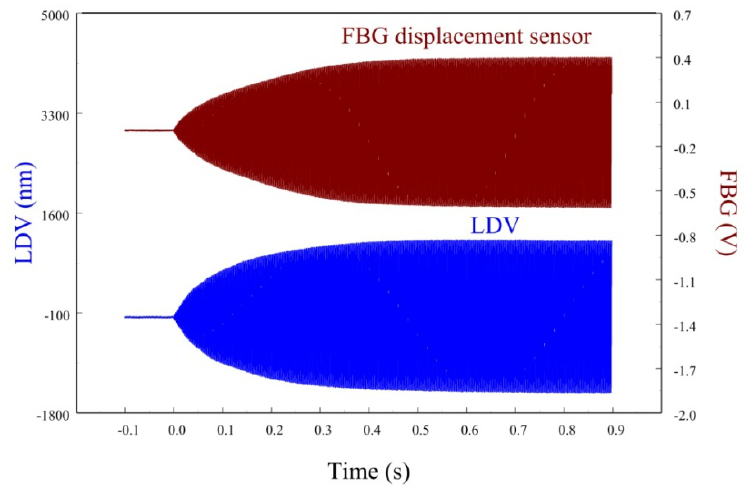
Figure 20. Transient displacement responses of the smart cantilever beam excited by the piezoelectric actuator at 400